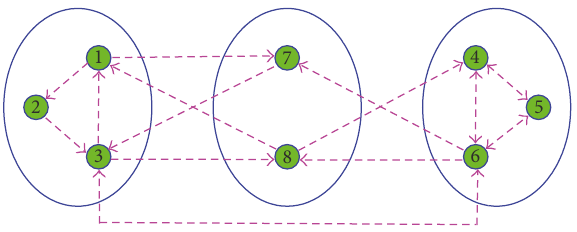
Figure 1: Topology structure of a directed network consisting of 8 nodes, which are divided into 3 clusters. If there is a directed link from node 𝑗 to node 𝑖 ( 𝑗 ̸= 𝑖 ), then 𝑎 𝑖𝑗 = 1 , otherwise 𝑎 𝑖𝑗 = 0